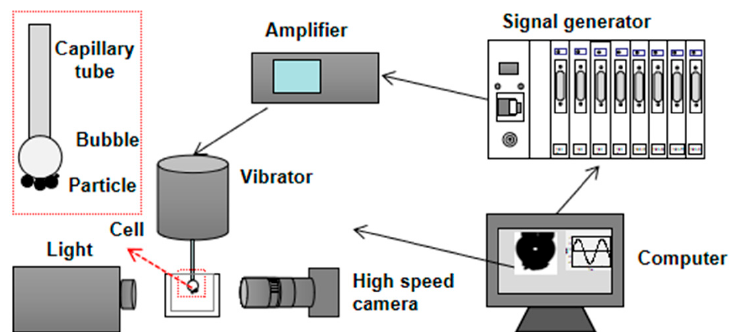
Figure 4. Schematic of the bubble–particle attachment/detachment testing system.